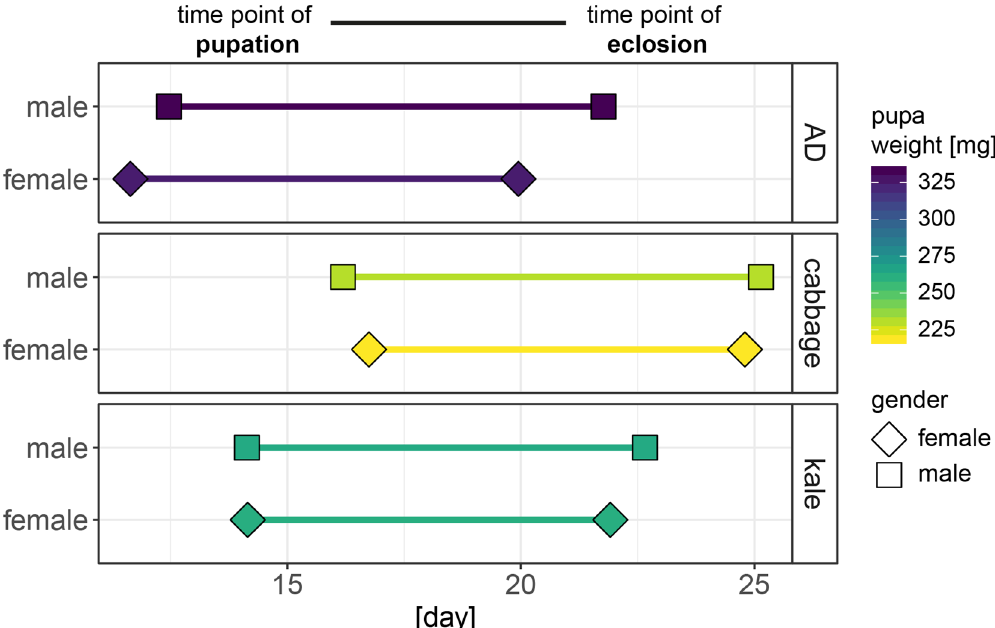
Figure 3. Time to pupation or completion of the larval stage (left data point) and time to adult eclosion (right data point) in days since hatching. The line represents the overall time as a pupa, the colour highlights the pupal weight (taken 24 h after start of pupation). Males are depicted as boxes, females as diamonds, n = 44 – 92. Means ± SE and statistical information can be found in Figure S4 and Table S3.